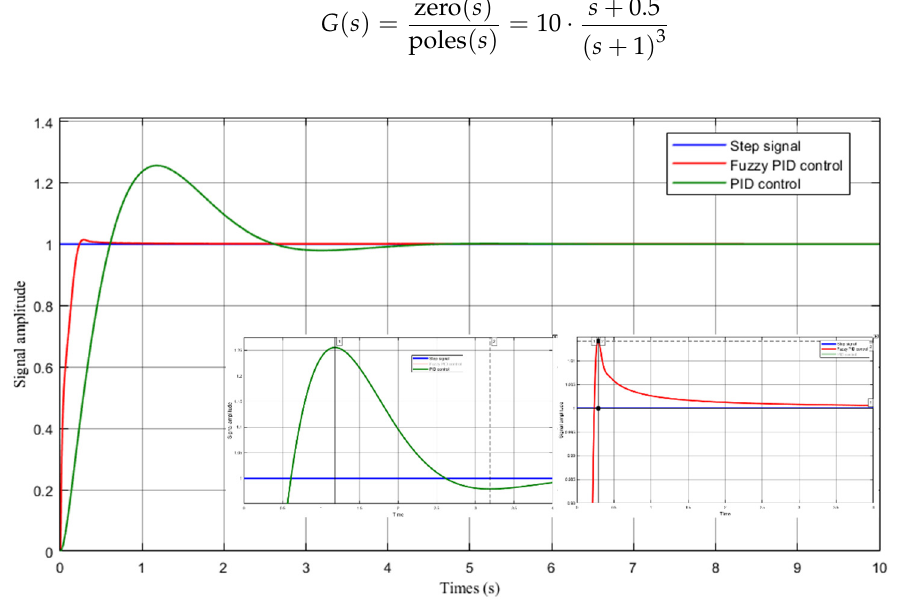
Figure 12. Simulation response curve of control system: Step signal tracking simulation .